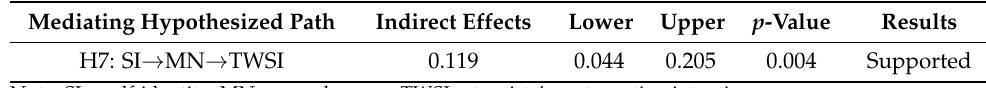
Table 5. Mediation test